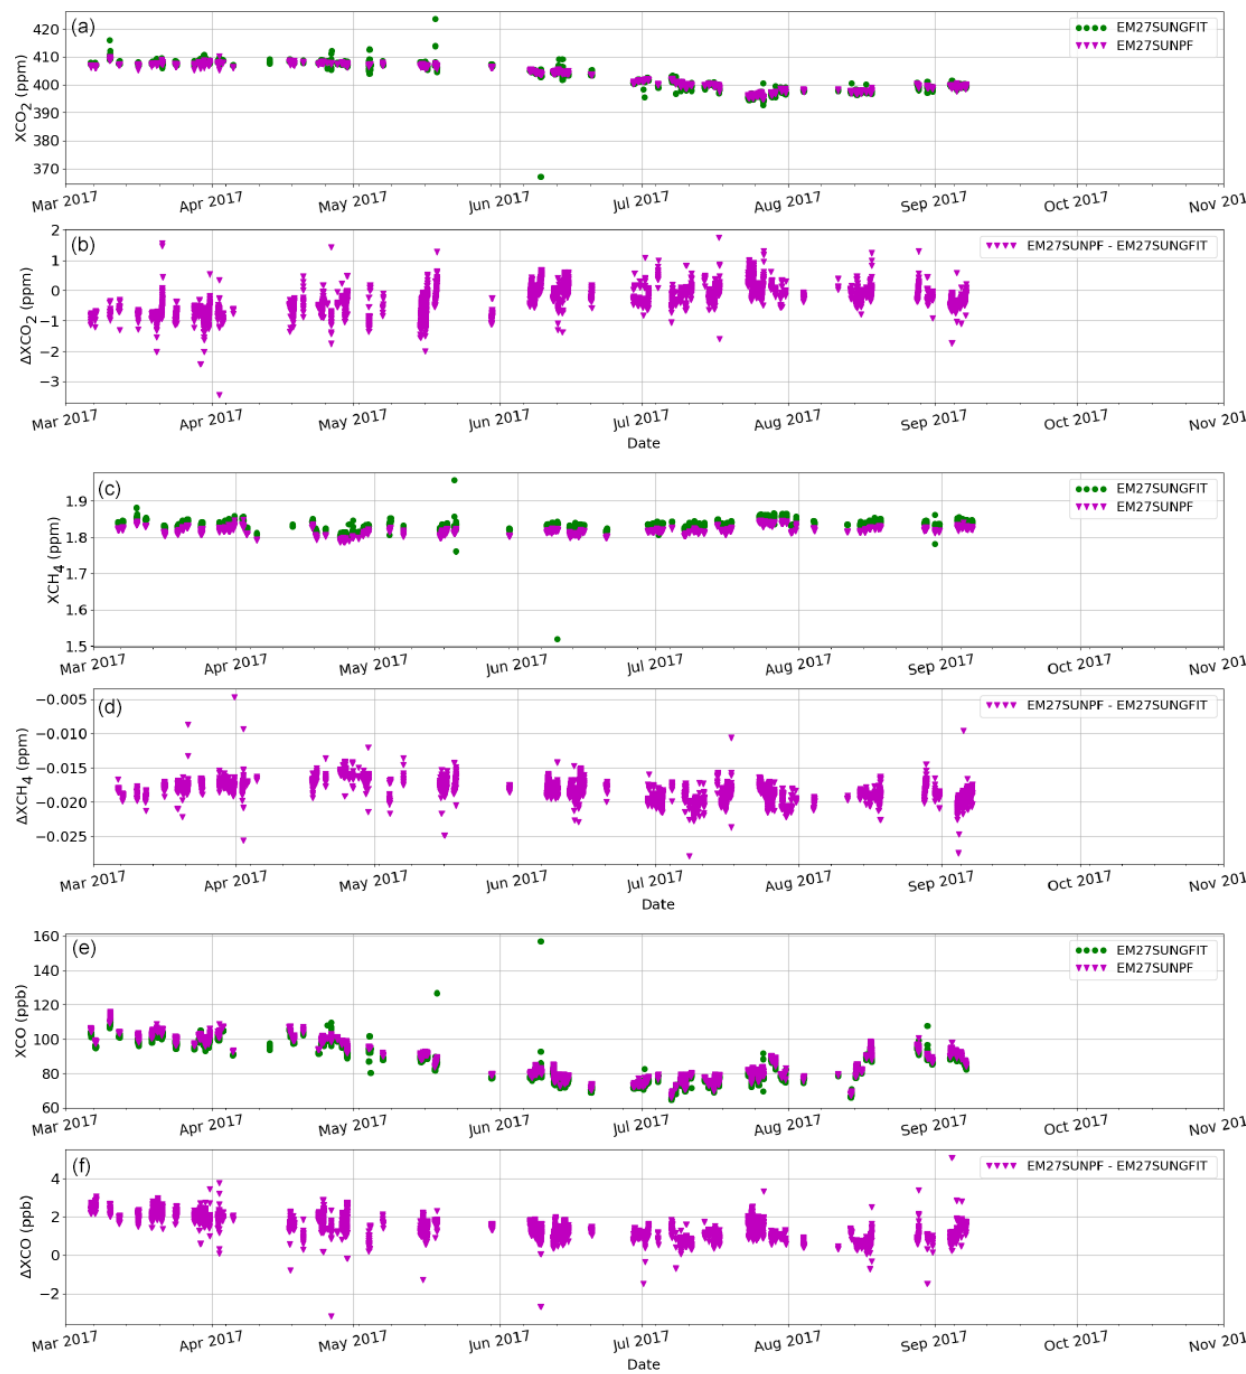
Figure 12. Time series of XCO 2 (a) , XCH 4 (c) , and XCO (e) retrieved from EM27/SUN measurements processed following the COCCON recommendations (EM27SUNPF) and using GFIT (EM27SUNGFIT) for measurements performed at Sodankylä in 2017. The difference of XCO 2 (b) , XCH 4 (d) , and XCO (f) time series for the EM27SUNPF relative to the EM27SUNGFIT analysis as a